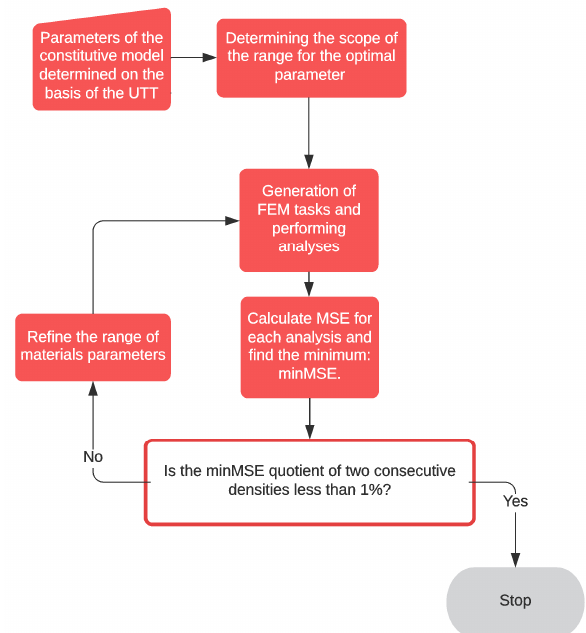
Figure 7. Inverse analysis algorithm—parametric study.